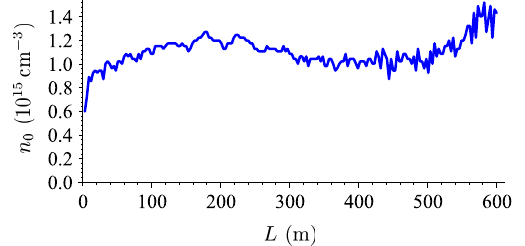
distance.FIG. 7. (Color) Relative witness energy gain as a function of the driver energy for two dimensionless amplitudes of the plasma wave.